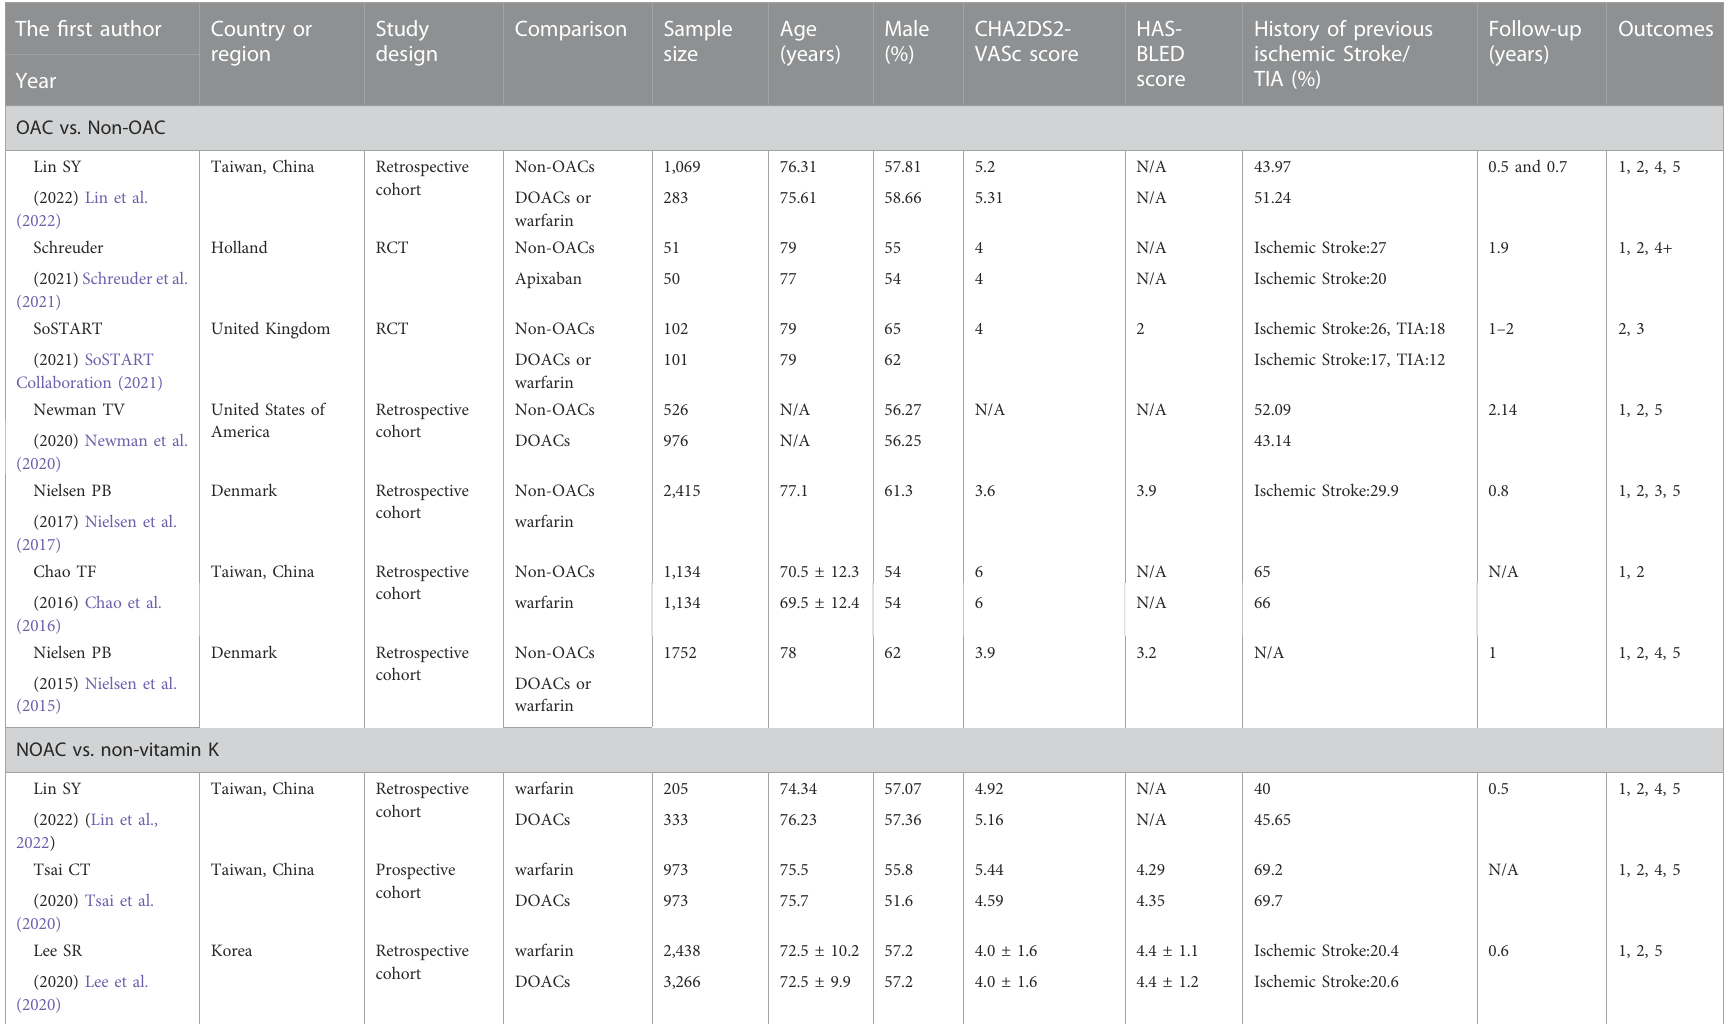
TABLE 1 Baseline characteristics of included